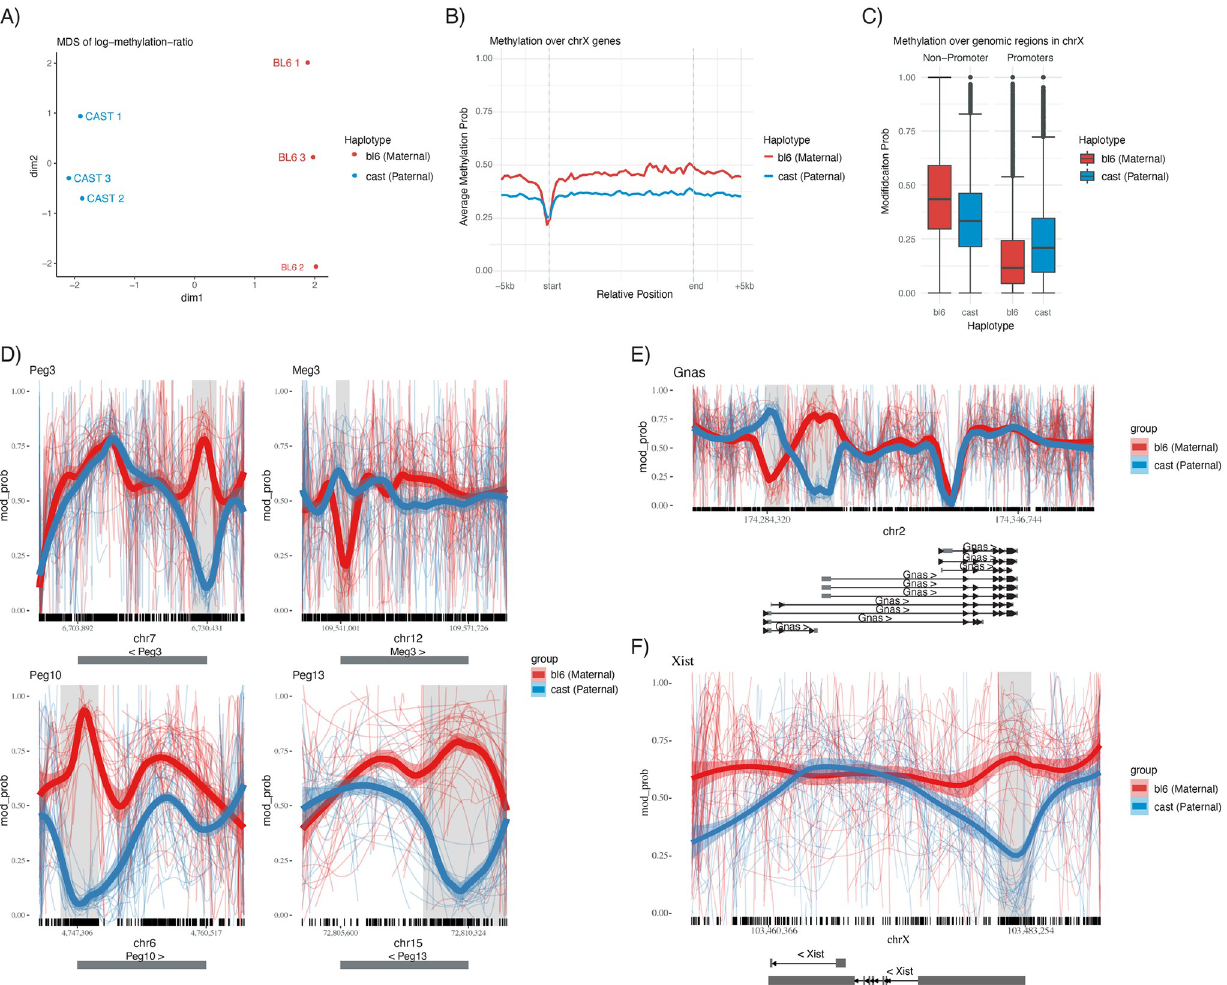
Fig 2. Summary of the plotting capabilities of NanoMethViz . A) Multidimensional scaling plot of haplotyped samples. B) Aggregated methylation profile across all genes in the X-chromosome, scaled to relative positions. C) Box plot of methylation probabilities over promoter and non-promoter regions for the BL6 and CAST haplotypes. D) Spaghetti plots of known imprinted genes Peg3 , Meg3 , Peg10 and Peg13 . Thin lines show the smoothed methylation probability on individual long reads, the thick lines show aggregated trend across the all the reads. The shaded regions are annotated as DMR by bsseq , and the tick marks along the x-axis show the location of CpG motifs. E) Spaghetti plot of Gnas , which shows two adjacent regions of opposite imprinting patterns. F) Spaghetti plot of Xist , a gene expressed from the inactive X chromosome.